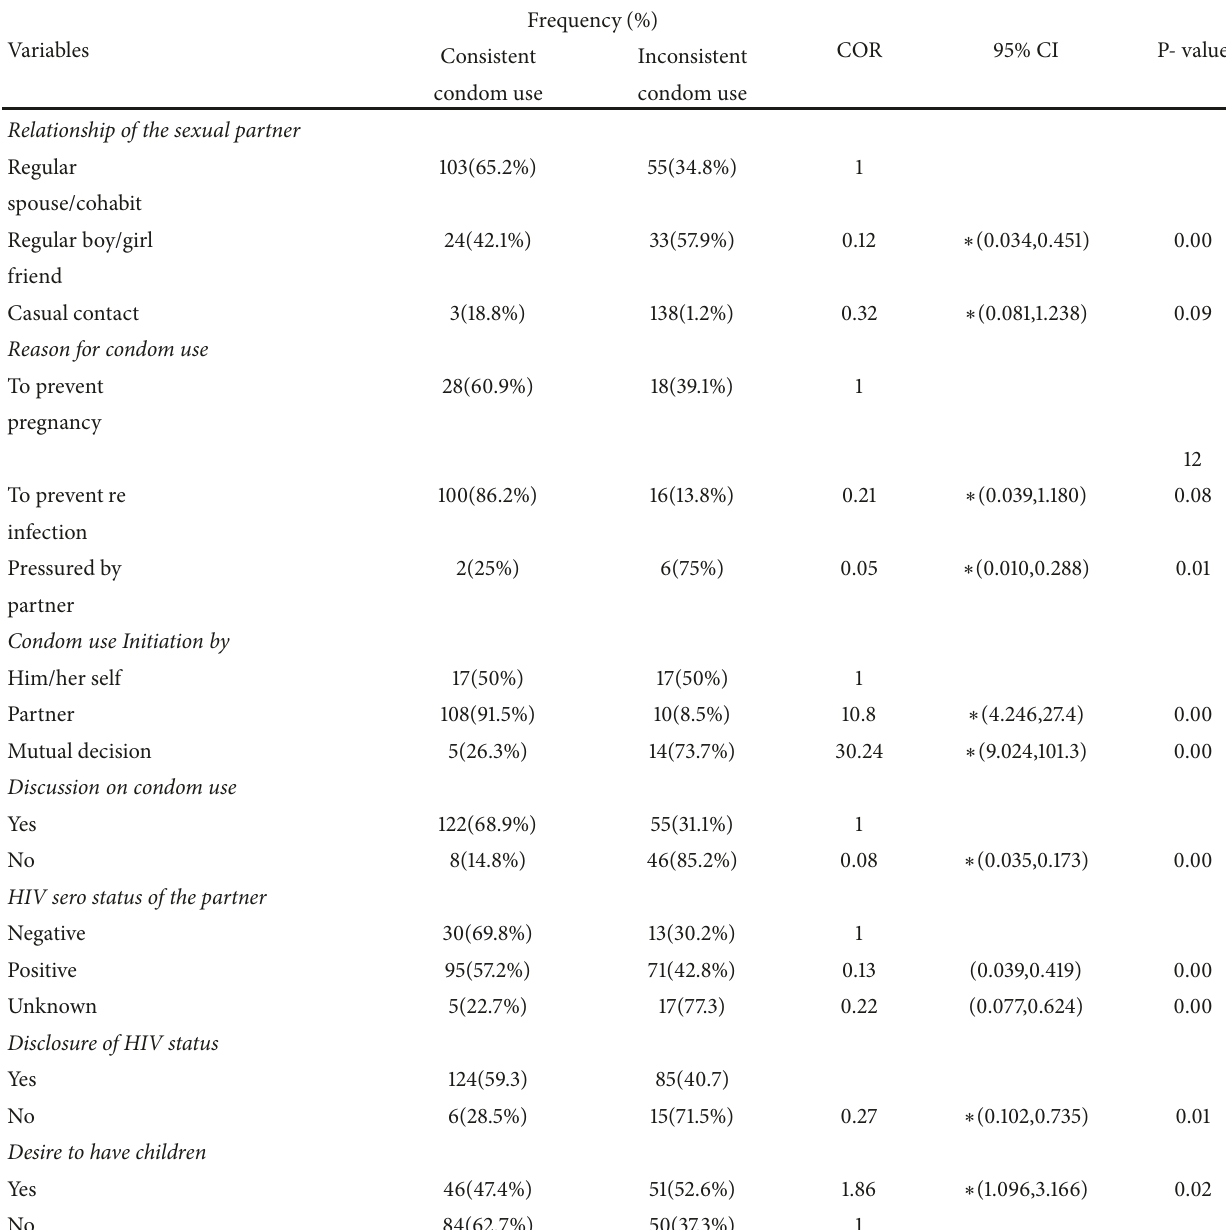
Table 5: Bivariate analysis of sexual behaviors of respondents with consistent condom use in Kollidiba health center, North West Ethiopia